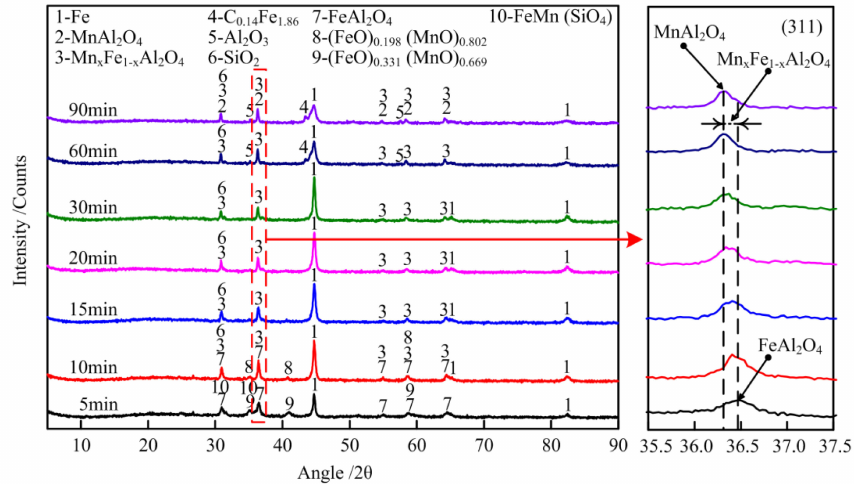
Figure 8. XRD patterns of the reduced mixed samples at 1300 ◦ C under FC/O of 1.0 with proportion of Fe-Al ores/Fe-Mn ores of 7/3 for different reduction roasting